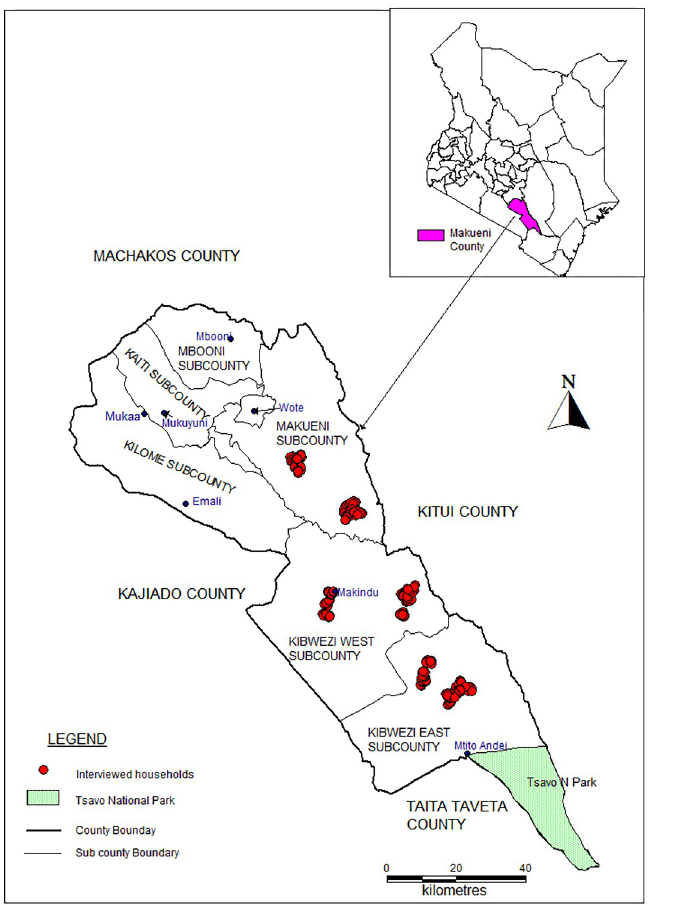
Fig 1. A map showing study area with GPS points of households